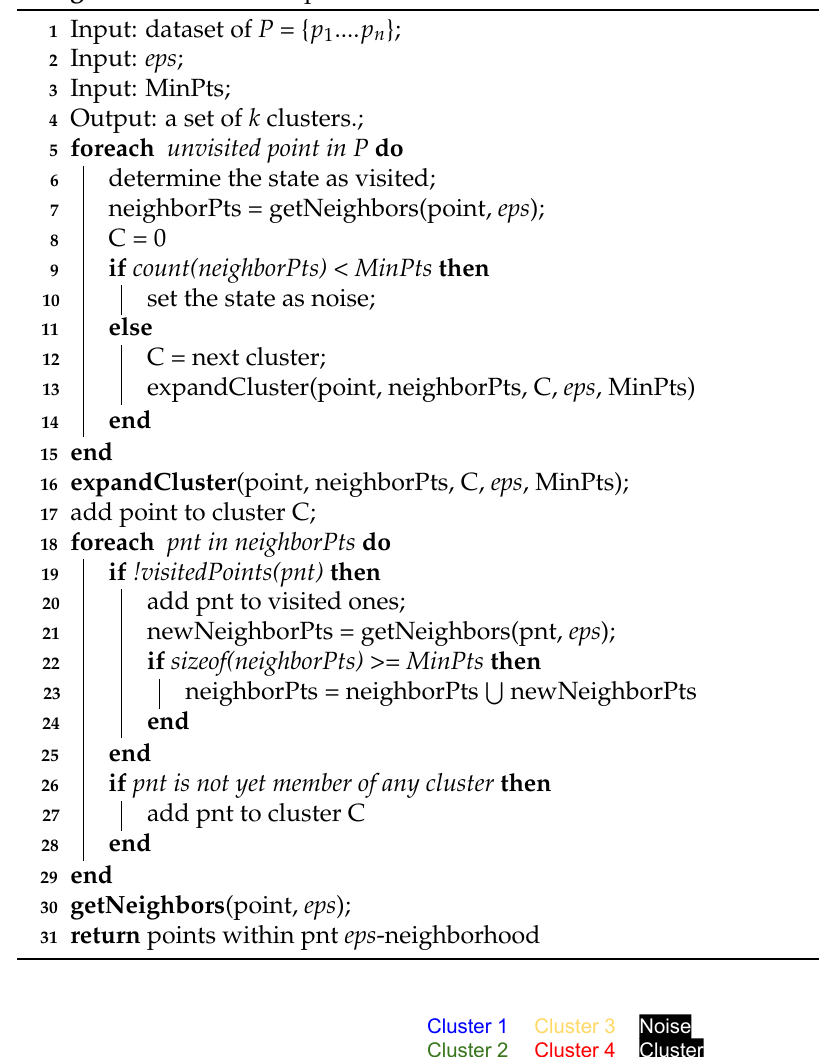
Algorithm 2: DBSCAN pseudo-code.